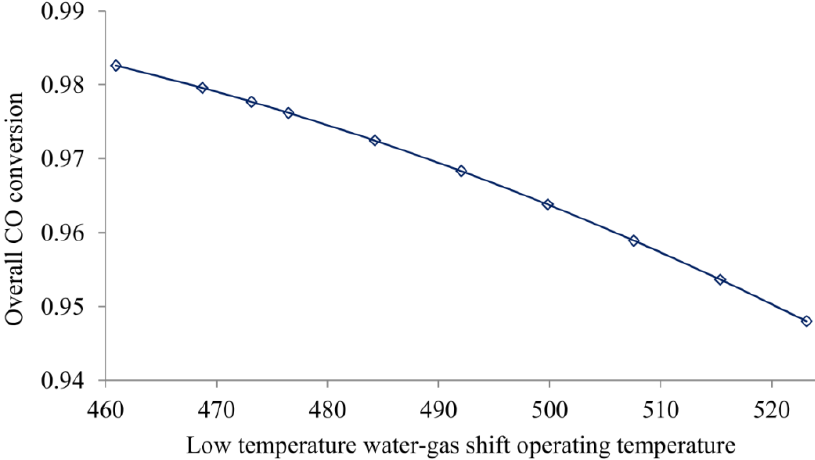
Figure 3. Effect of operating temperature on overall CO conversion in the shift reactors with O to coal ratio: 0.8, solid concentration in coal slurry: 0.65, WGS process SDG: 0.59, 2 and HTS reactor operating temperature: 623 K as fixed